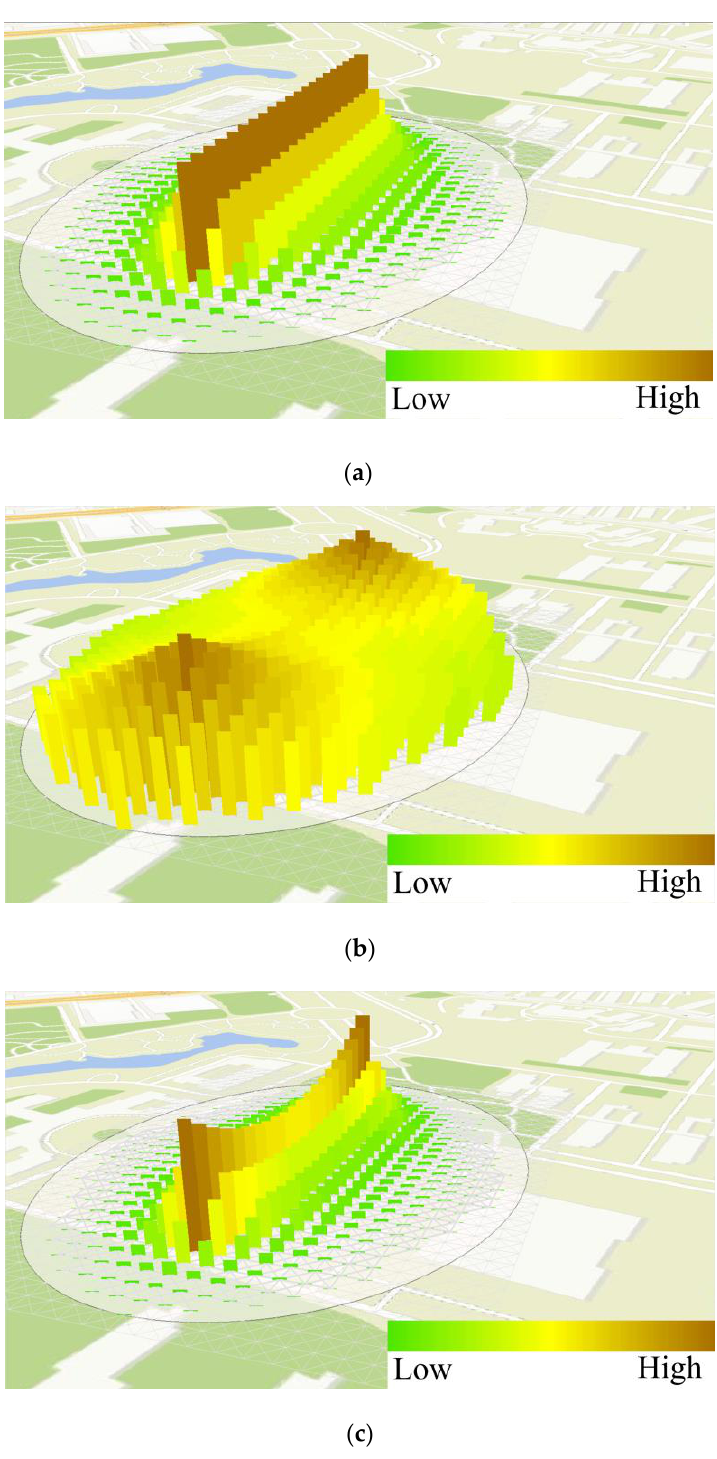
Figure 4. Saddle-shaped kernel function ( c ) composed of “ ridge ” ( a ) and “ peak ” ( b ). Taking time as a measure, the numerator is [0, 2 a − 2 c ] and the denominator is a con- stant 2 a − 2 c , so the value range of the fraction is [0, 1]. Note that 2 c is subtracted from both the numerator and denominator, which is one of the differences between Equations (3) and (2). The purpose is to standardize the fraction range from [ c / a , 1] to [0, 1]. Since the inverse distance weights (IDWs) of the fractional values {0 (at the focal length line), c / a , 1 (at the boundary)} are {max, middle, min}, Equation (3) can expand the interval length and weaken the boundary effect. Another difference is that the cost measure of path LCP- x uses 𝑡 𝑝 (𝑠, 𝑒|𝑥) instead of 𝑡 𝑝 (𝑠, 𝑥) + 𝑡 𝑝 (𝑥, 𝑒) . Since the former considers the cost of turn- ing at point x and the latter does not, the two are not always equal. For example, in Figure 5, the PNA is composed of three road sections R 1 , R 2 and R 3 . Their minimum costs are 11, 12 and 13, respectively. The cost of turning right at x from R 1 to R 3 is 2, and the cost of going straight at x from R 2 to R 3 is 0. Then, 𝑡 𝑝 (𝑠, 𝑒|𝑥) = R 2 (12) + straight (0) + R 3 (13) = 25, while 𝑡 𝑝 (𝑠, 𝑥) + 𝑡 𝑝 (𝑥, 𝑒) = R 1 (11) + R 3 13) = 24 and R 1 (11) + right (2) + R 3 (13) = 26. Therefore, the replacement of 𝑡 𝑝 (𝑠, 𝑥) + 𝑡 𝑝 (𝑥, 𝑒) in Equation (3) by 𝑡 𝑝 (𝑠, 𝑒|𝑥) can improve the accu- racy of cost measurement and accordingly improve the density estimation.